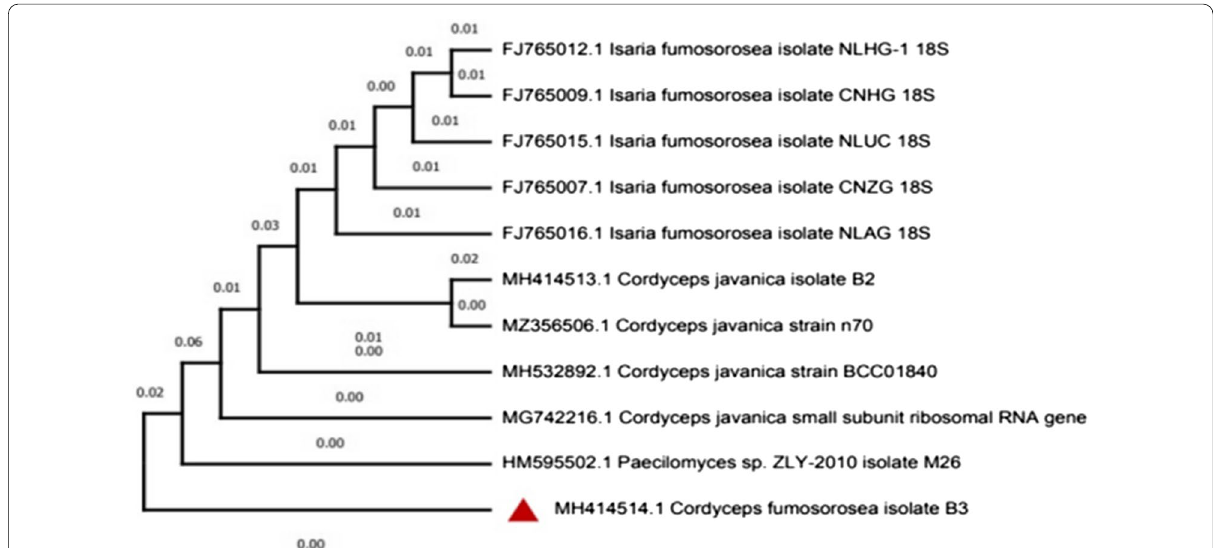
Fig. 3 Phylogenetic tree of MH414514.1 sequence and its closest homologs inferred using Neighbor-Joining method in MEGA v6. 1.0. The numbers of nodes represent the percentage of boot strap value obtained from 1000 sampling. Bar 0.01 shows the substitutions per nucleotide position